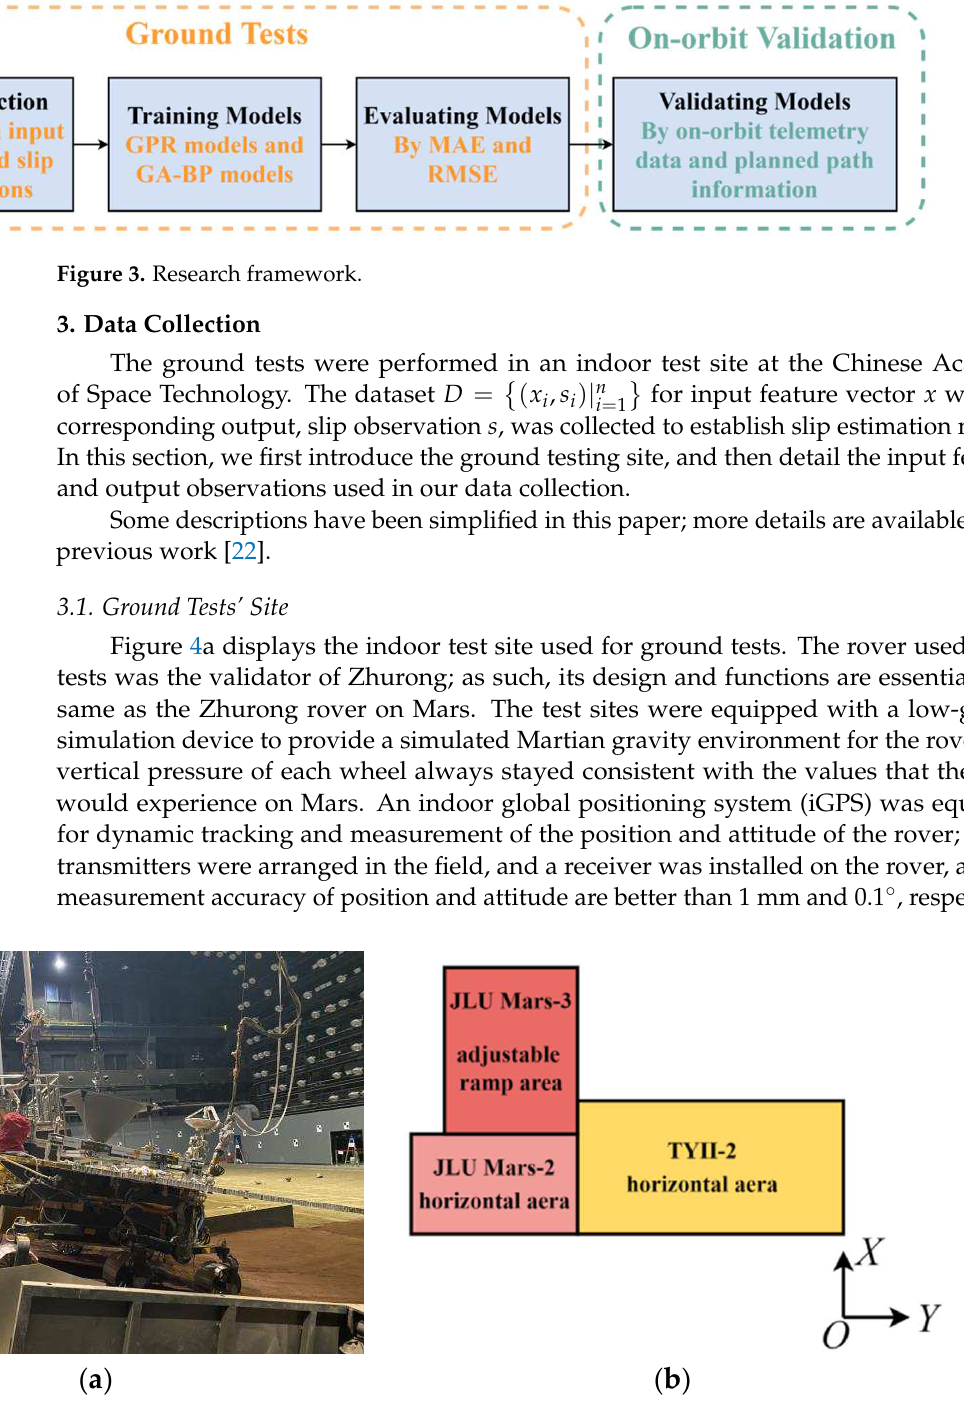
j c : cohesion; : internal friction angle; k: shear deformation modulus;